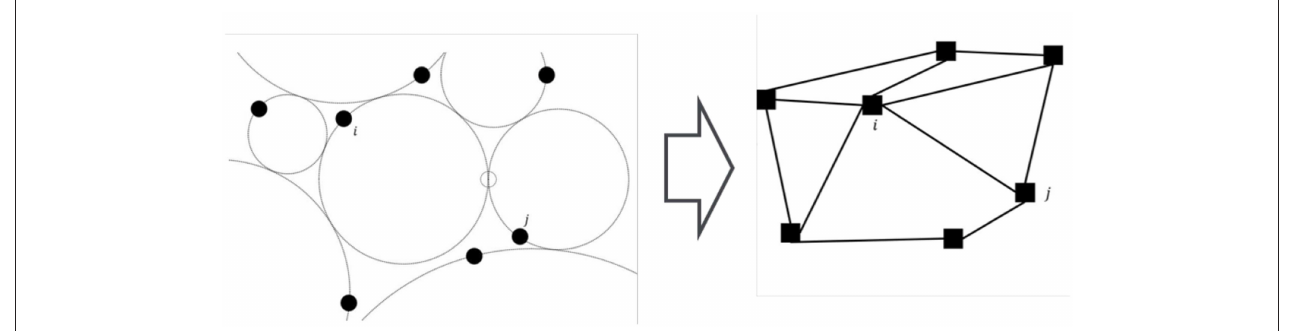
FIGURE 5 | The layout of seven agents on their orbits, and the abstraction to a